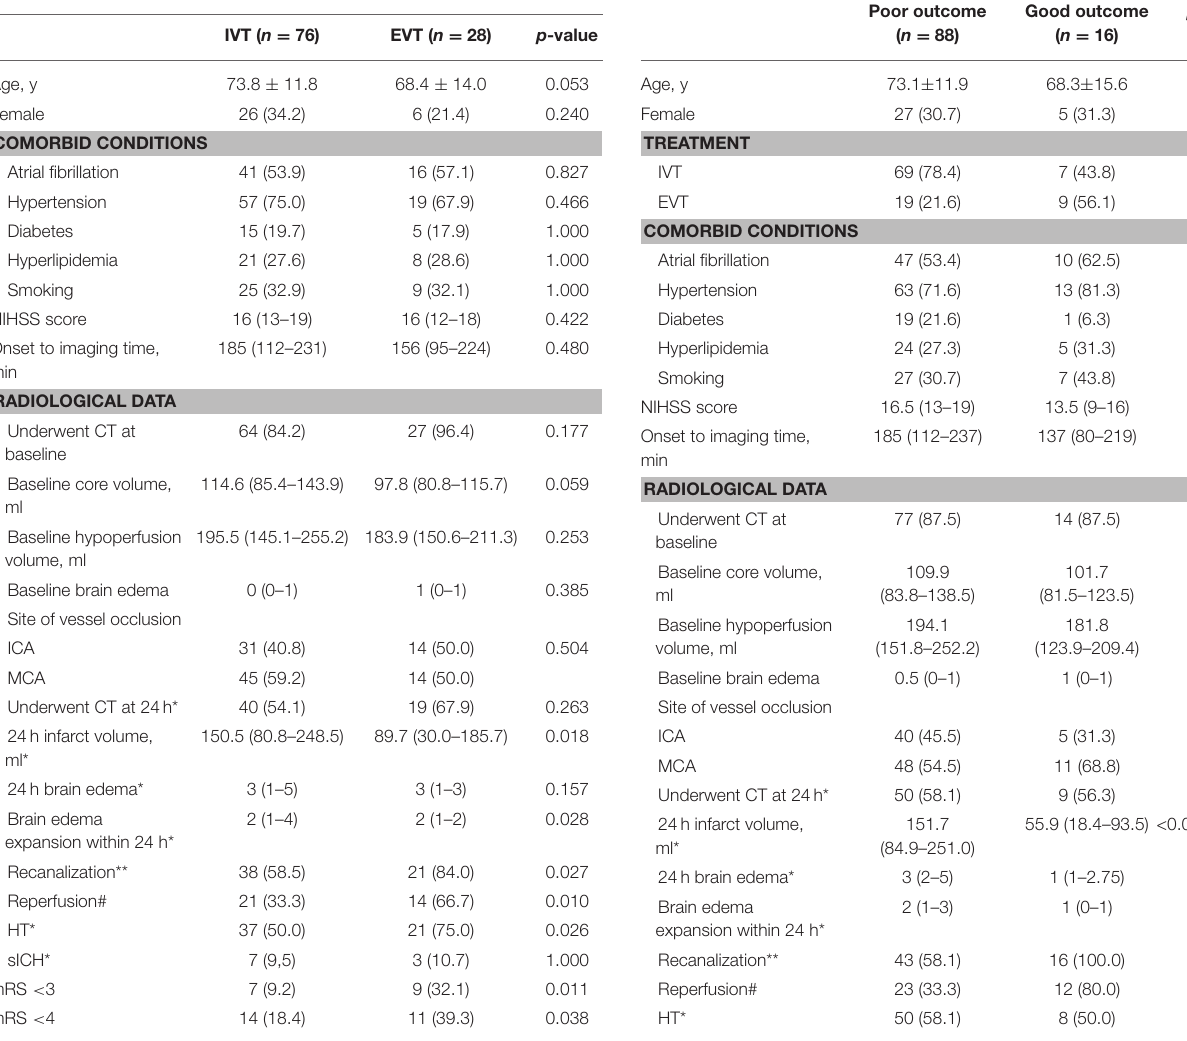
TABLE 1 | Clinical and imaging characteristics of patients who underwent different therapies.